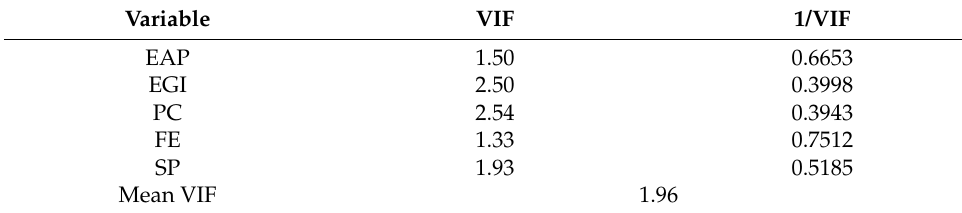
Table 4. The multicollinearity test for each variable.